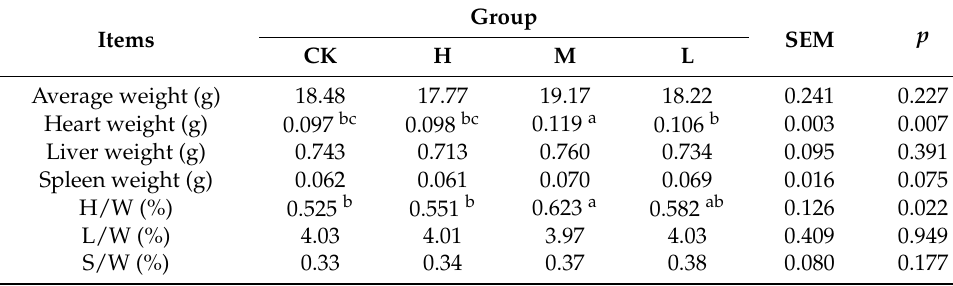
Table 3. Effect of ALE on heart, liver and spleen of